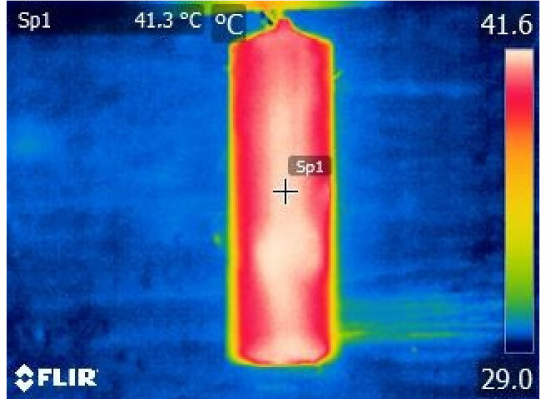
Figure 11. Placement of the measurement point SP 1 on each thermogram while the measurements are in